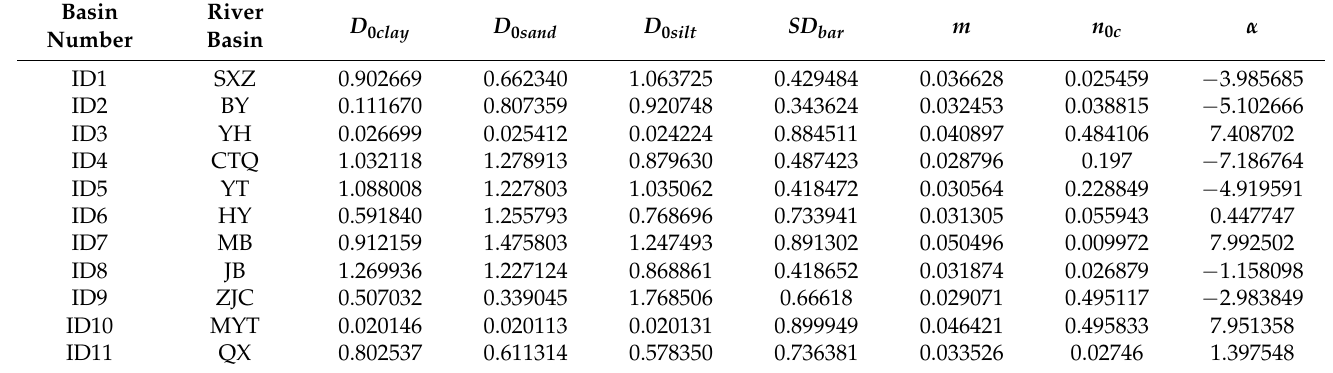
Table 4. Model calibrated parameters of 11 study